Question: What kind of plot is shown here?
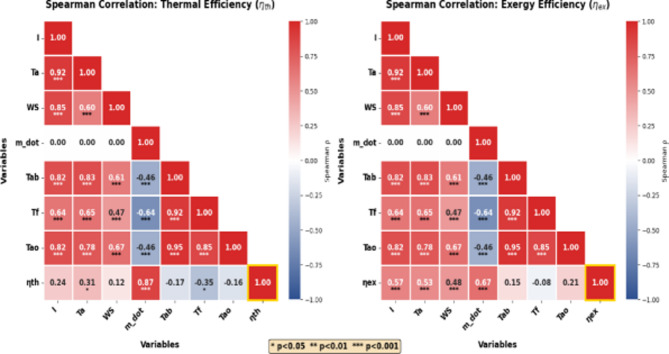
Answer: heatmap